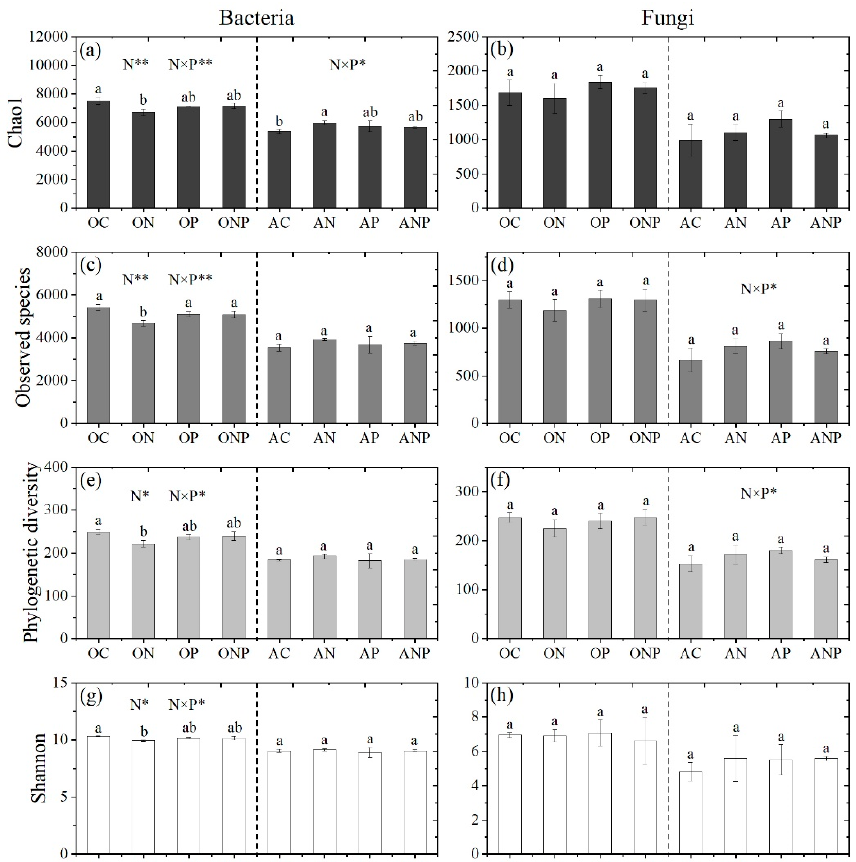
Figure 1. Soil bacterial ( a , c , e , g ) and fungal ( b , d , f , h ) diversity index (Chao1 ( a , b ), Observed species ( c , d ), Phylogenetic diversity ( e , f ) and Shannon ( g , h ) under N and P additions. Different letters above the bars indicate significant differences (one-way ANOVA, p < 0.05, Duncan’s multiple range test) among different fertilization addition treatments. N, P and N × P showed the effects of N, P and NP interaction on bacterial and fungal diversities, respectively (two-way ANOVA, * p < 0.05, ** p < 0.01). OC, ON, OP and ONP indicate the O horizon soils (0–5 cm) under control (C, without N and P addition), N addition, P addition and NP addition, respectively. AC, AN, AP and ANP indicate the A horizon soils (5–15 cm) under control (C, without N and P addition), N addition, P addition and NP addition, respectively.